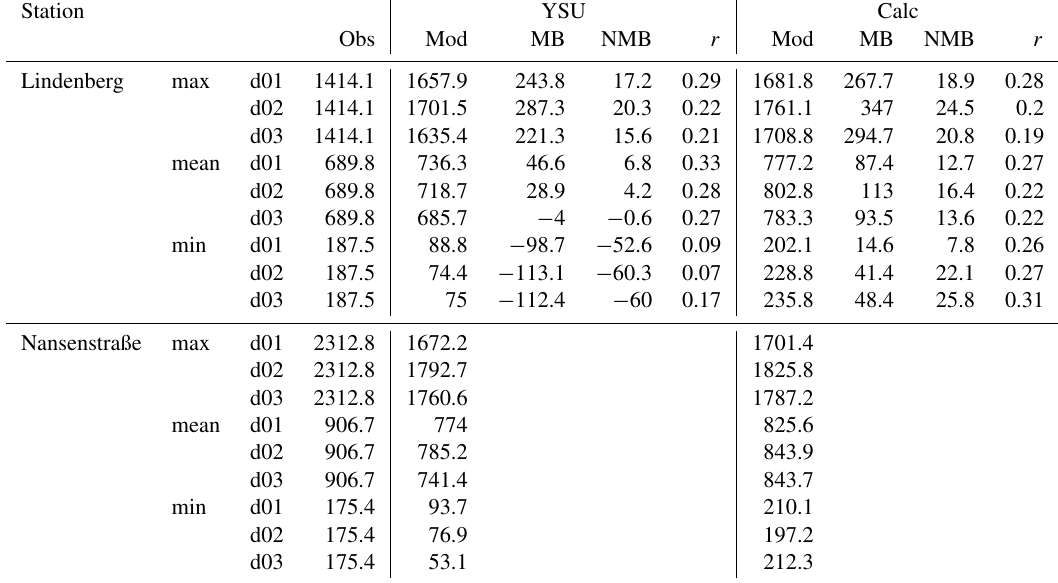
Table 6. Statistics of daily minimum, mean and maximum mixing layer height for JJA. “Obs” refers to the JJA observed mean, “Mod” refers to the JJA modelled mean for the respective grid cell. MB is the mean bias for JJA, NMB refers to the normalised mean bias and r is the correlation of hourly values. The values given in the column “YSU” refer to the MLH diagnosed directly by WRF-Chem, while “Calc” refers to the MLH calculated from modelled profiles of temperature, wind speed and humidity. Obs, Mod and MB are given in metres and NMB is given in %. The statistics are shown for the results from the model domains of 15km (d01), 3km (d02) and 1km (d03) horizontal resolution. Station YSU